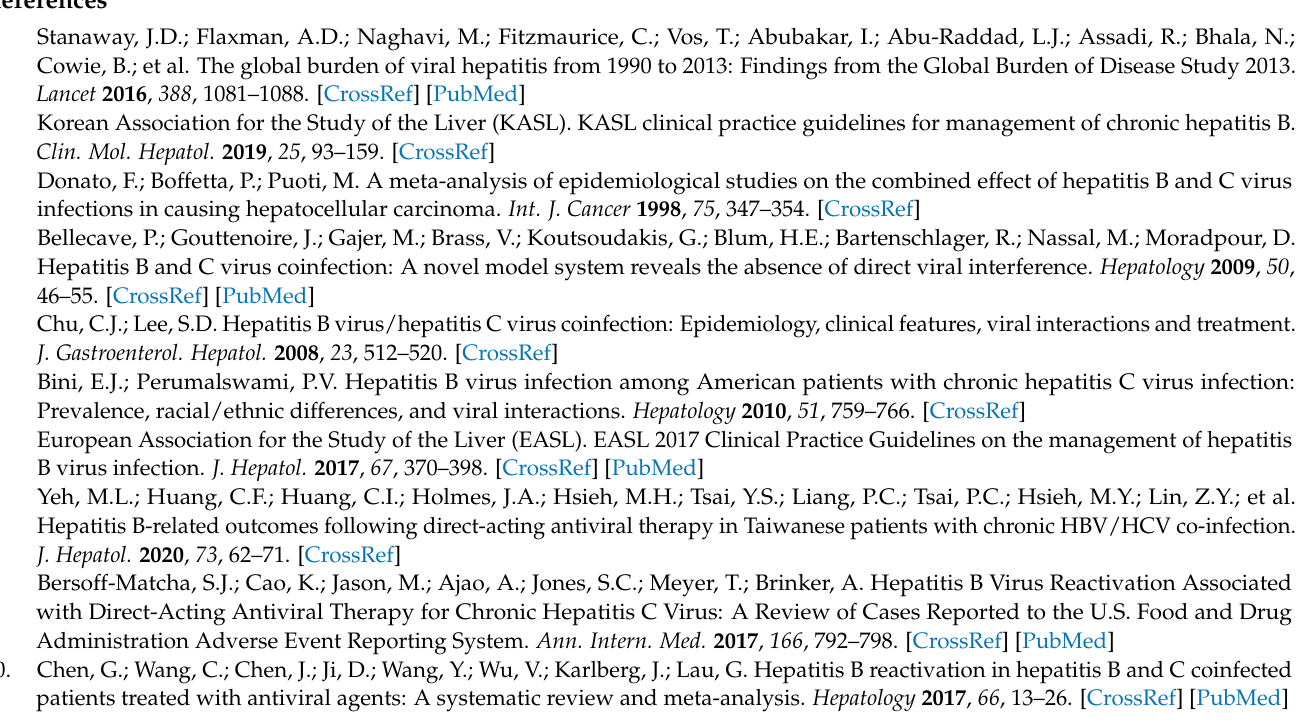
Figure S2: Risk of bias, Figure S3: Funnel plot for analysis publication bias; Table S1: Search strategy and